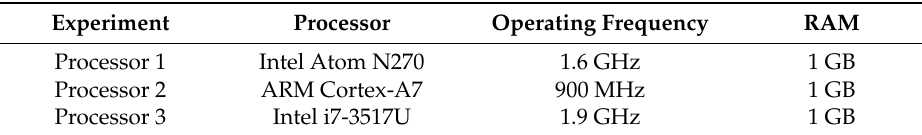
Table 2. Processor-based